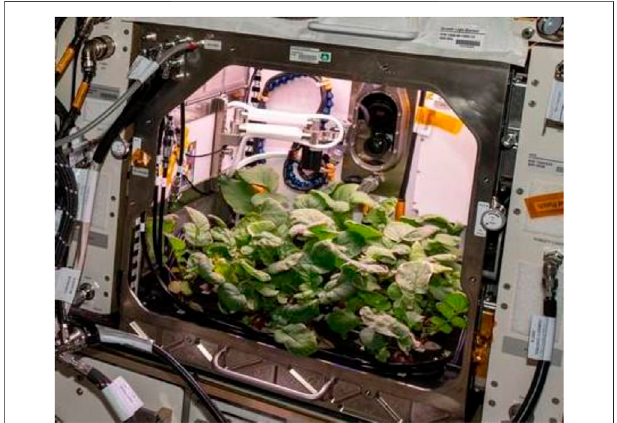
FIGURE 2 | Leafy greens grown on the International Space Station (Meggs et al., 2010) .